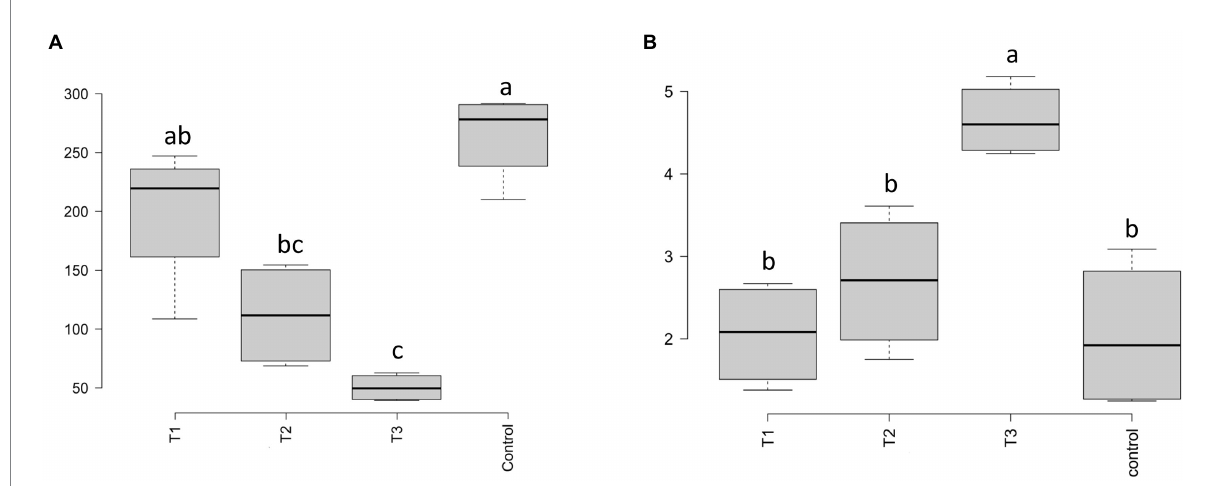
α -diversity values according to the Simpson’s D index for bacteria (A) and fungi (B) for each eluate dosage applied on bare soil ( p < 0.001). Different letters indicate significant differences according to the one-way ANOVA test carried out by Tukey’s HSD (Honest Significant Differences).